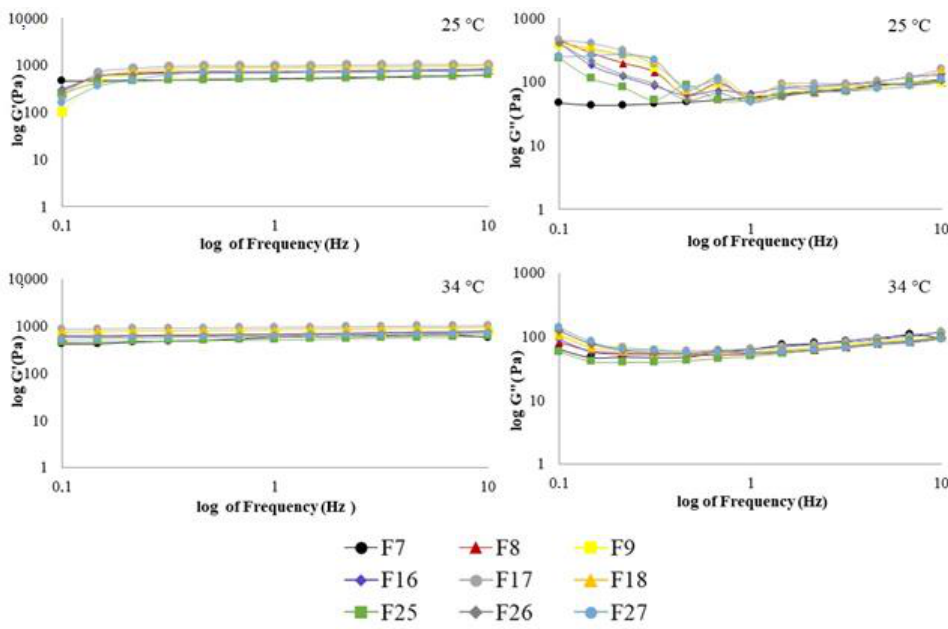
Figure 8. Elastic modulus (G’) and viscous modulus (G”) as a function of frequency of formulations containing AN oil. Each point is the mean of at least three replicates. Standard deviations have been omitted for clarity; however, in all cases, the relative standard deviation of replicate analysis was less than 10%.